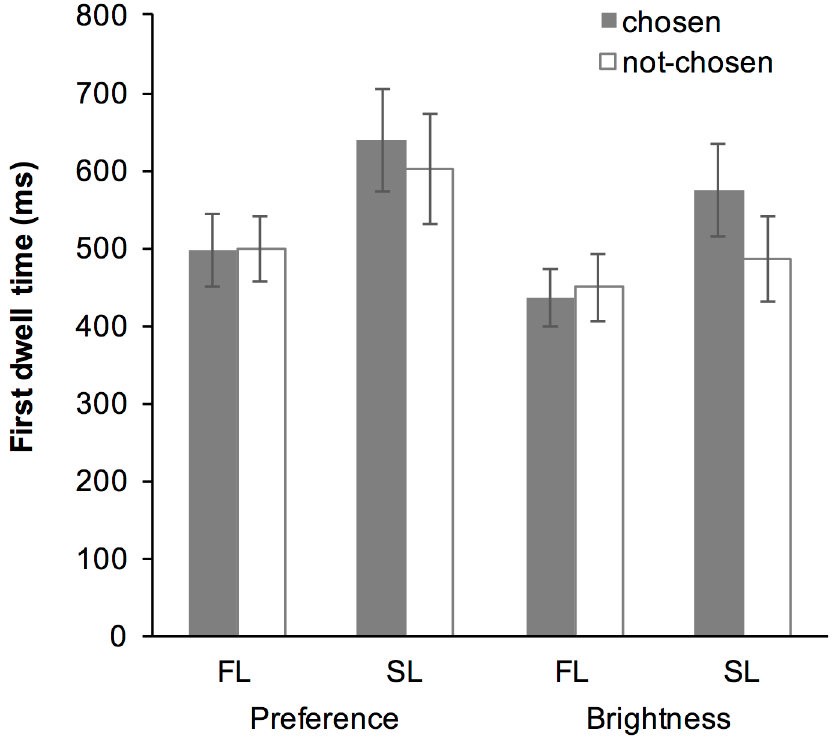
Fig 6. Averaged first dwell time in the snack block in Experiment 2. Error bars represent the standard error of the mean.